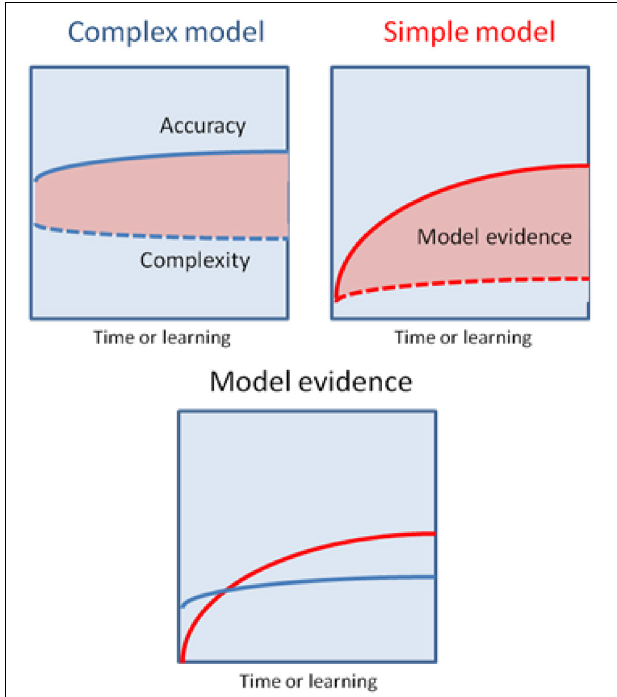
FIGURE 3 | This schematic illustrates the possibility that a more complex model may have greater model evidence at the start of learning but will then give way to a simpler model as their parameters are optimized. The upper panels show the learning-related improvement in accuracy and complexity for a complex model (left panel) and a simple model (right panel). The model evidence is shown as the difference (pink areas). The more complex model explains the data more accurately but with a greater complexity cost, that is finessed during the learning. Conversely, the simpler model will always have a lower accuracy but can (with learning) attain greater model evidence—and thereby be selected by Bayesian model averaging as time proceeds and the active inference becomes